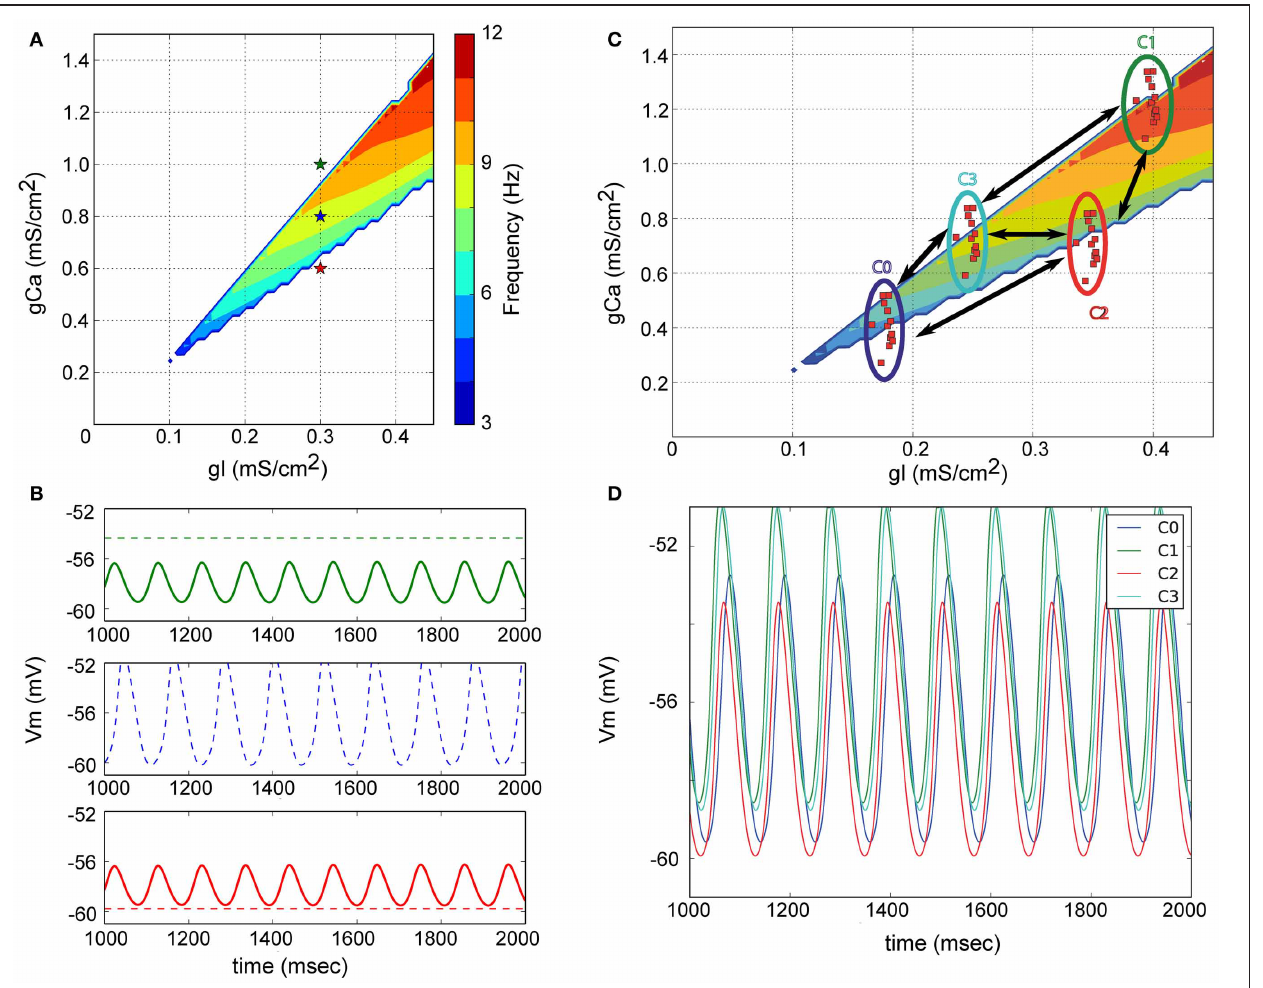
FIGURE 2 | Origin of subthreshold membrane potential oscillations in a model of the inferior olive. (A) Model neurons only contain a leak and low-threshold calcium current. The parameter space for the associated conductances is illustrated. The colored region delineates the region in parameter space where neurons spontaneously oscillate. (B) Non-oscillating neurons can become oscillators due to electrical coupling. Color of the membrane potential traces correspond to the color of the indicated points in (A) . Dashed line is the potential of the cell when not coupled; full line after coupling. The model neurons indicated with red and green in (A) only